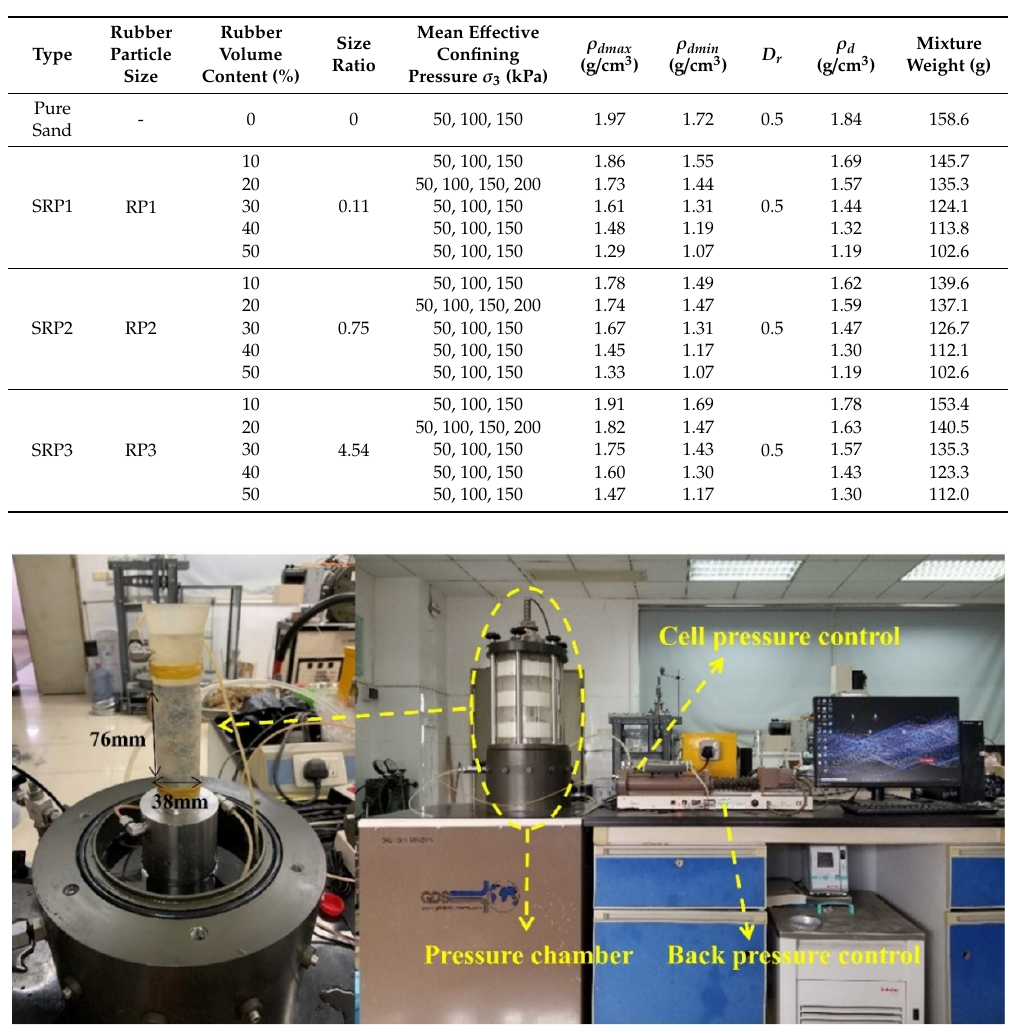
Figure 3. Typical sample diagram and experimental apparatus. Table 2. Experimental conditions of cyclic triaxial test.